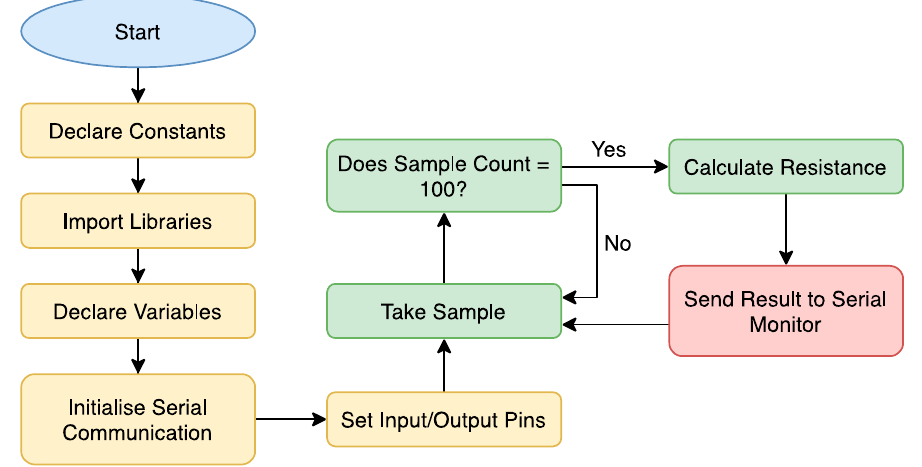
Sensors 2020 , 20 , x Figure 9. Software flowchart run on the microcontroller. Figure 9. Software flowchart run on the microcontroller.